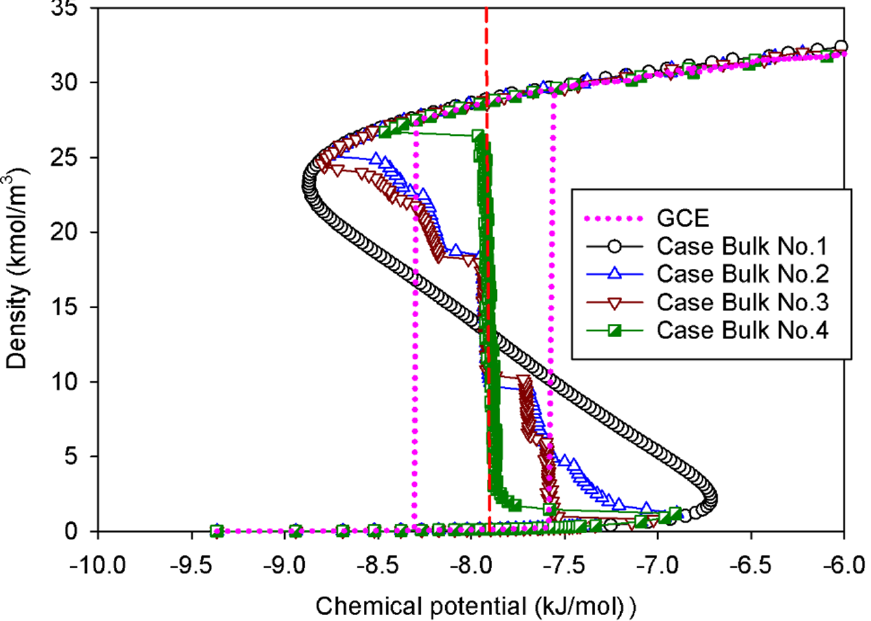
Figure 1. GCE and MCE isotherms of bulk nitrogen at 77 K in four different cases. The red vertical dashed line represents the vapor–liquid phase coexistence at chemical potential of − 7.88 kJ/mol.